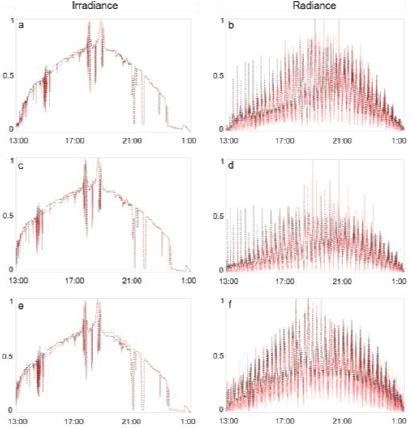
Figure 3. Green ( a , b ), red ( c , d ) and NIR ( e , f ) normalized irradiance and radiance measured with UDC (dashed black) and JC (dotted red). Since both instruments provide raw measurements in arbitrary units, the data shown here were linearly rescaled between minimum and maximum values (0–1). Time is GMT (hh:mm).